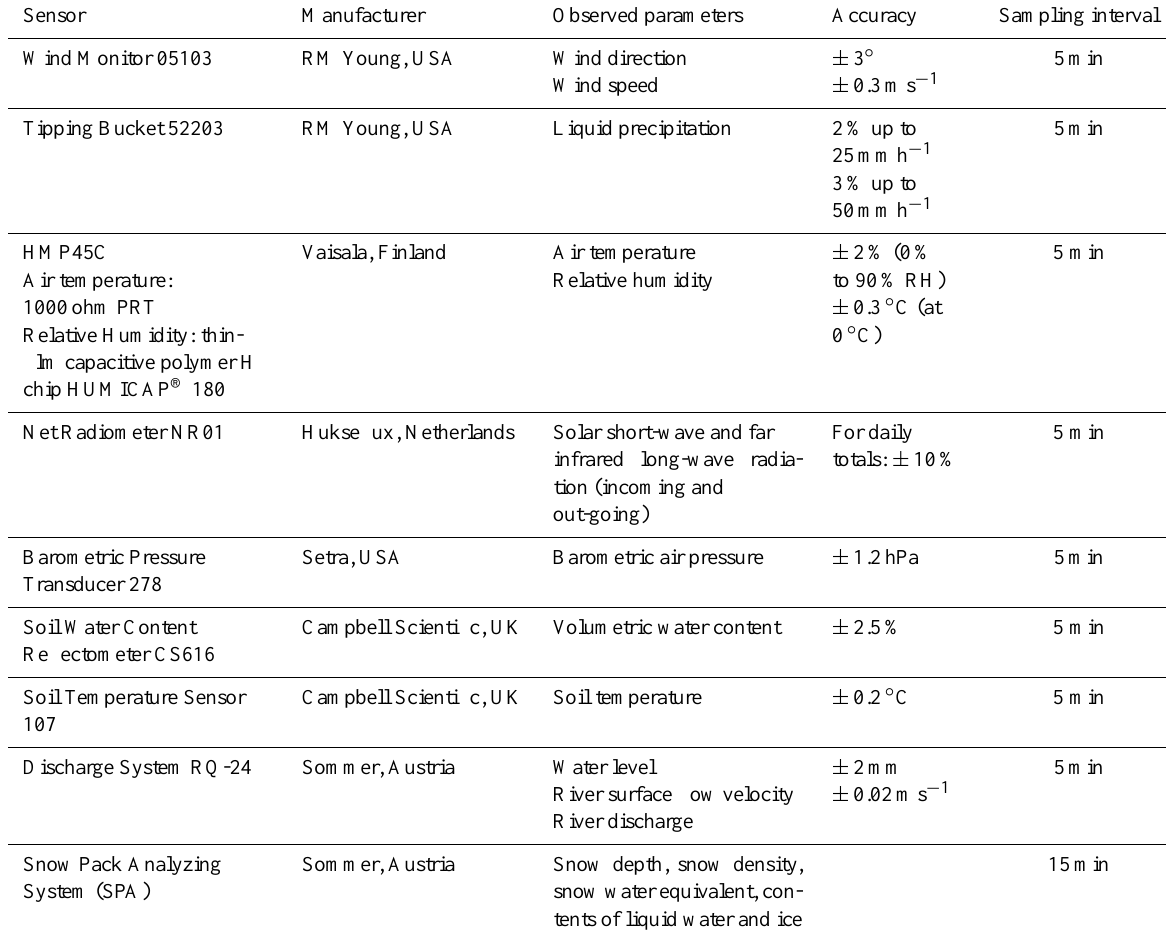
Table 1. Primary hydrometeorological sensors used in the CAWa/GCO-CA network.